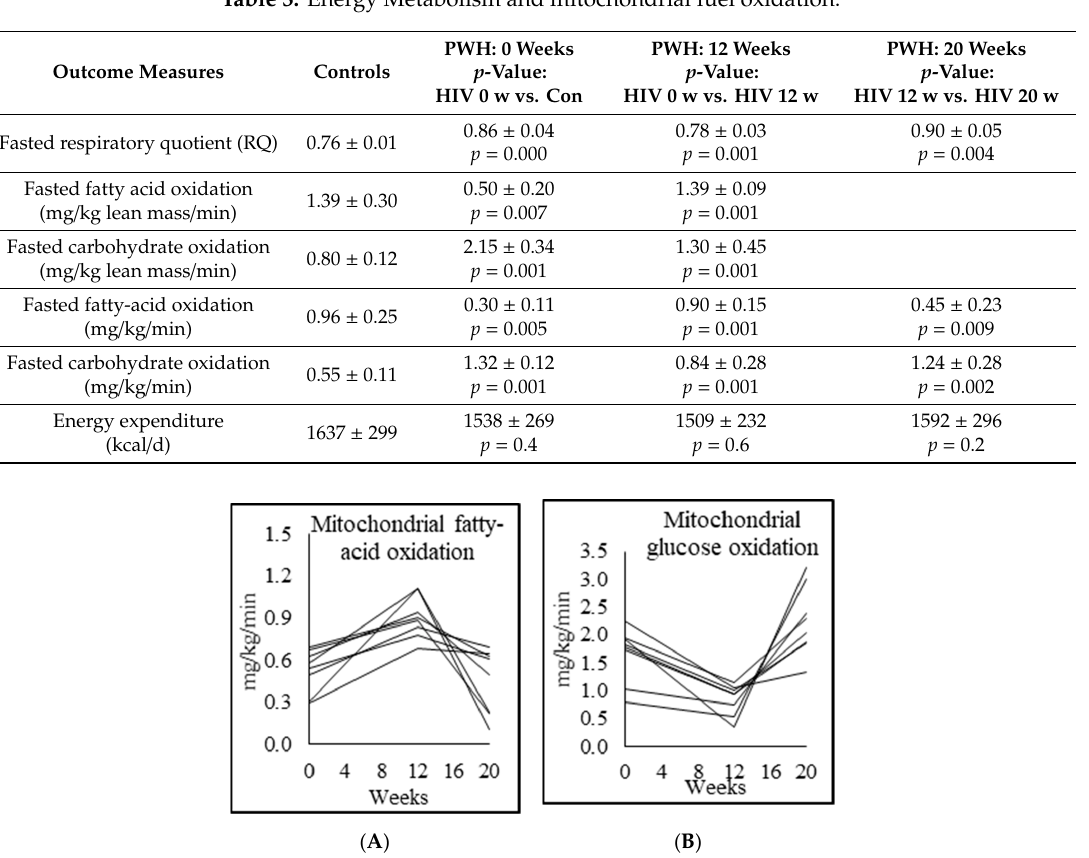
Table 3. Energy Metabolism and mitochondrial fuel oxidation.